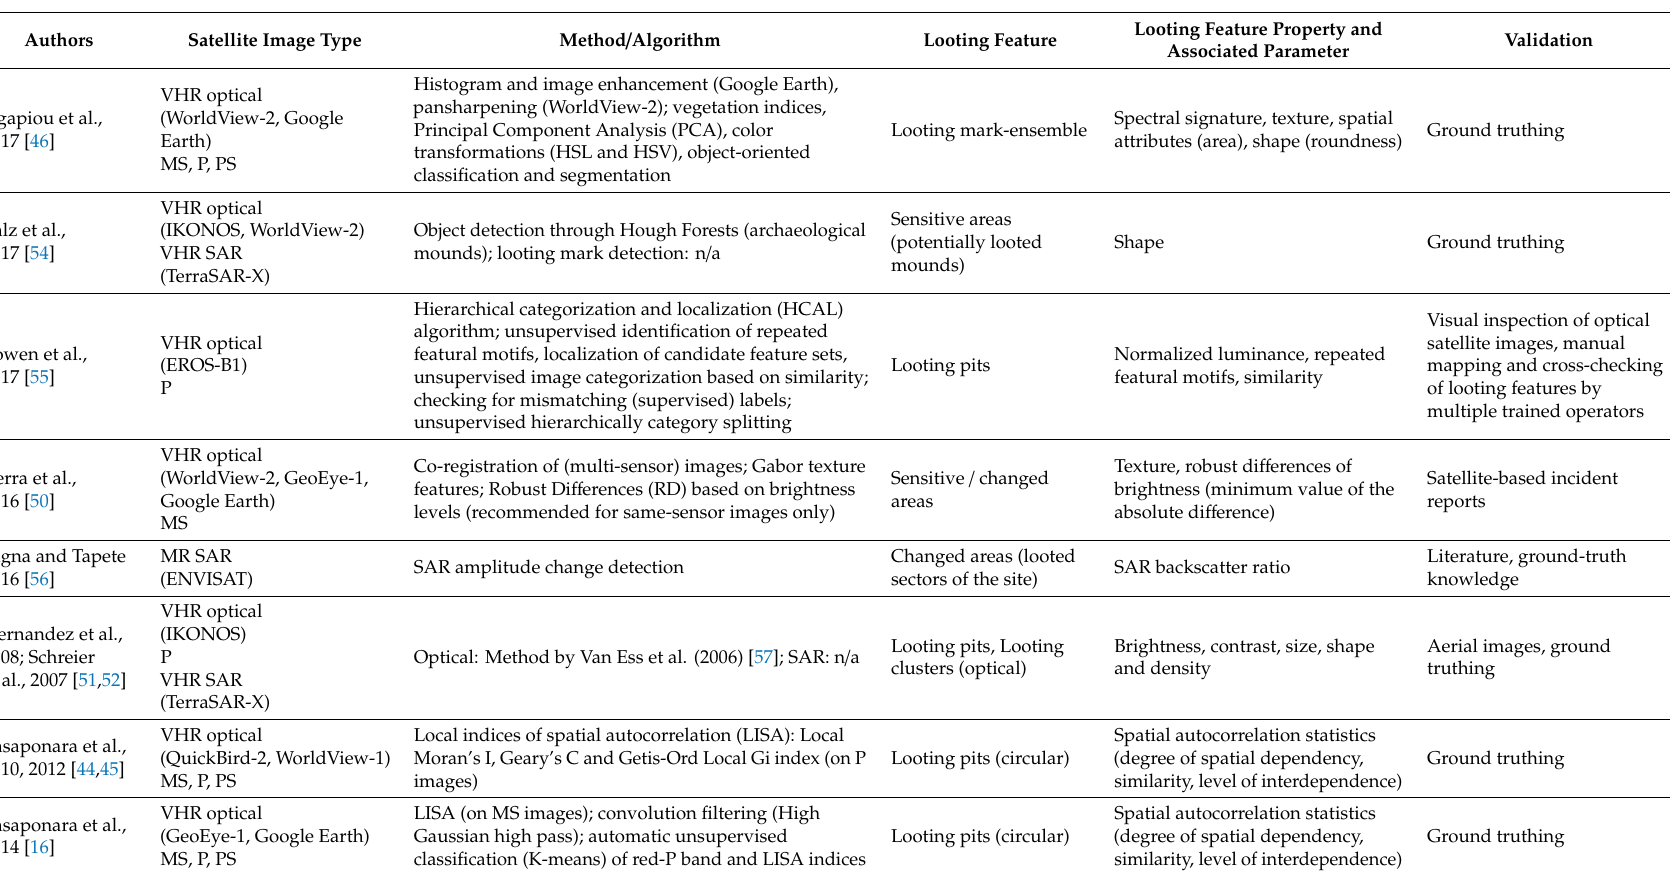
Table 3. Summary of image processing-based methods for looting assessment (published as of June 2019). Notation: MS—multispectral; P—panchromatic; PS—pansharpened; RGB—Red Green Blue true